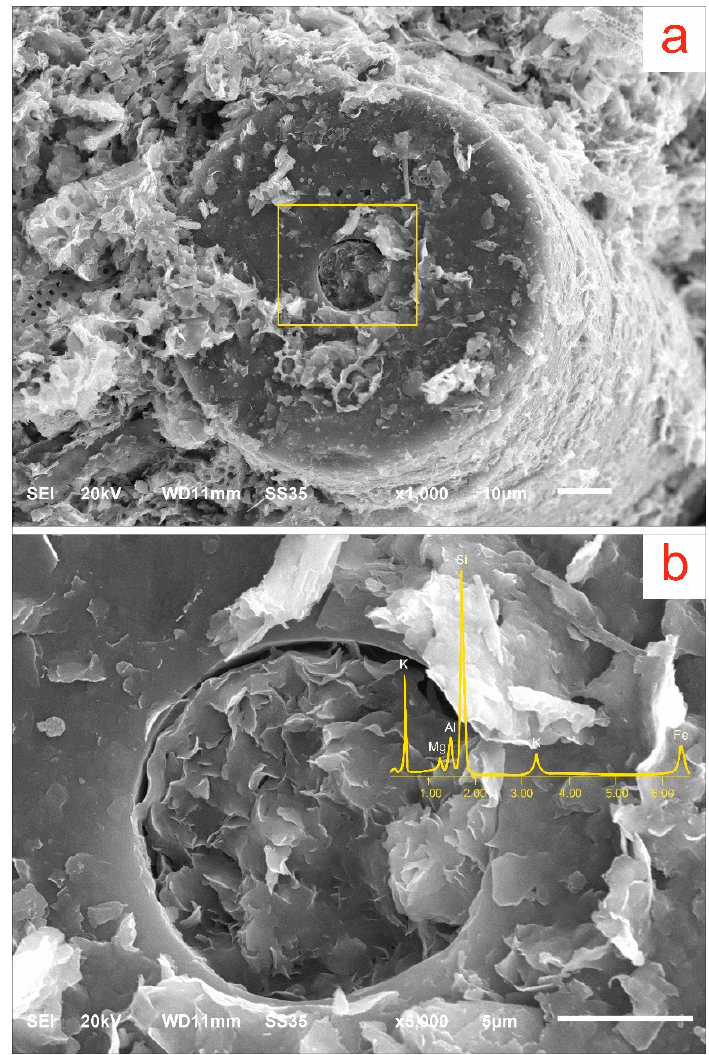
Figure 7. SEM images and EDS spectra of illite in the axis channel of a sponge spicule: ( a ) general view; ( b ) close-up view.